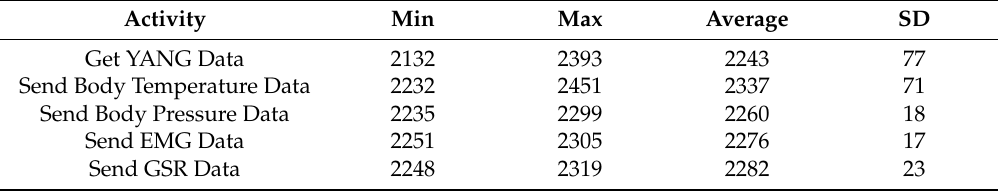
Table 5. Round trip time (RTT) in milliseconds for each IoTivity communication of activities.